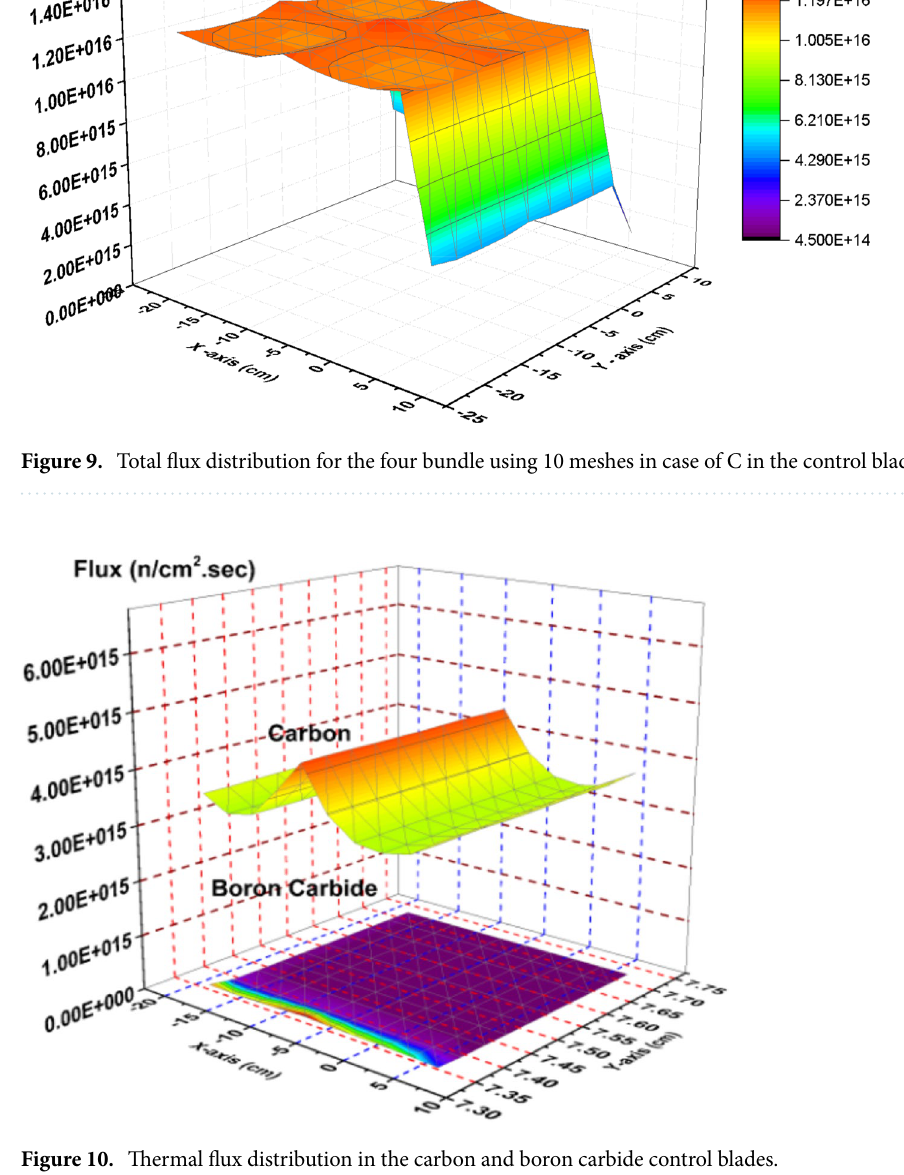
Figure 10. Thermal flux distribution in the carbon and boron carbide control